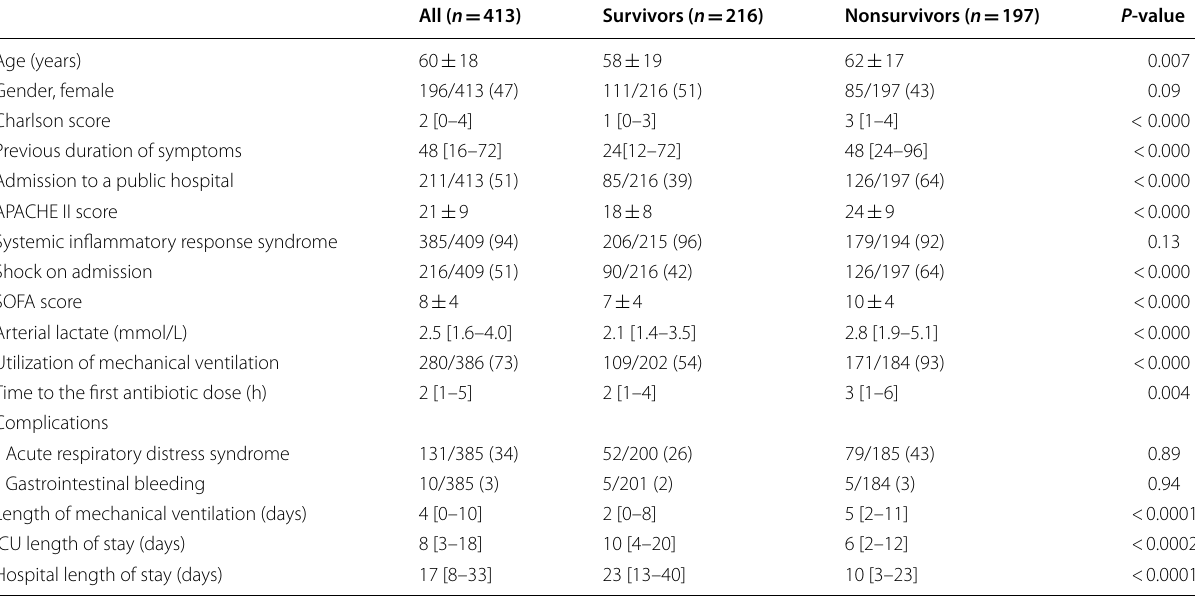
Data are shown as number (percentage), median [IQR] or mean